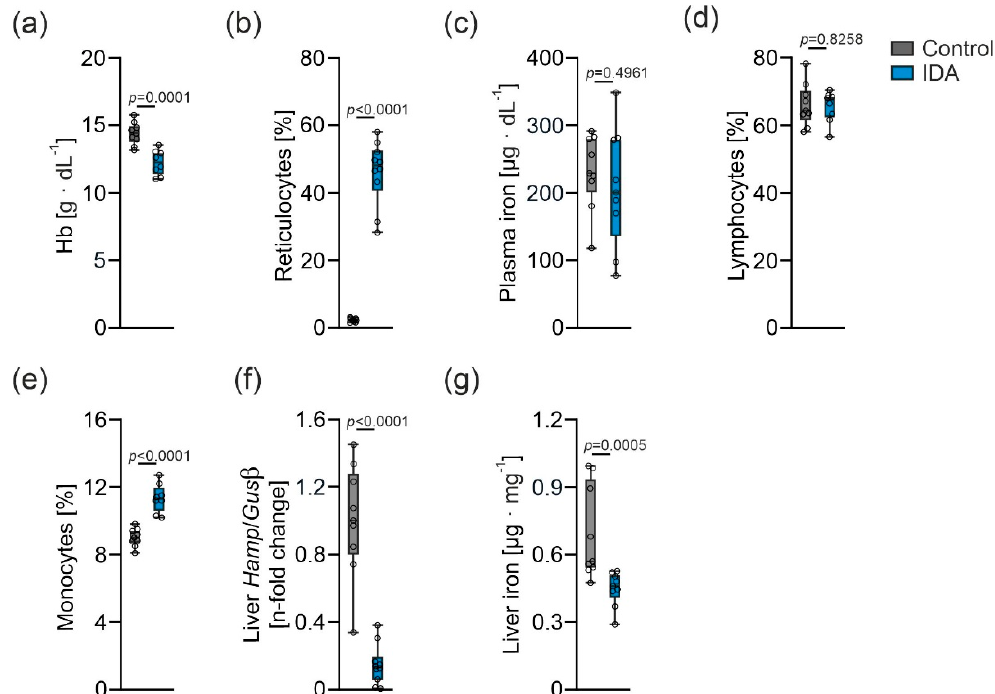
Figure 1. Alterations in blood and iron parameters caused by iron deficiency anemia (IDA). ( a ) He- moglobin (Hb) concentration, ( b ) reticulocyte proportion, ( c ) plasma iron concentration, ( d ) lym- phocyte fraction, ( e ) monocyte fraction, ( f ) liver Hamp mRNA expression relative to glucuronidase beta ( Gus β ), and ( g ) liver iron content. Control: N = 9 rats, IDA N = 10 rats. An unpaired two-tailed Student’s t-test was applied for all normal distributed results; a Mann-Whitney U-test was applied for the nonparametric result shown in ( g ). Values are shown as median ± interquartile range. p - Values are shown in the graphs.